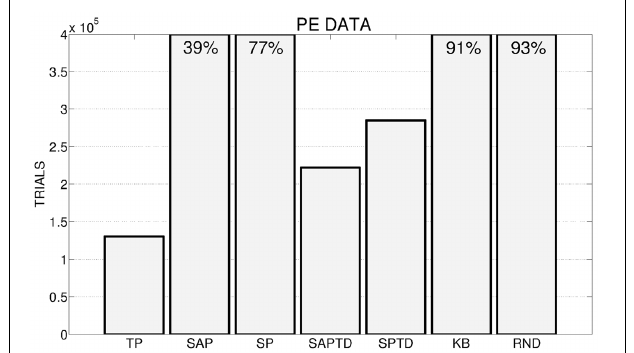
FIGURE 4 | Average number of trials needed by the different conditions to achieve an average performance of 95% in the 4 learnable tasks (average results of 180 replications: 20 replication by 9 learning rates for the systems with predictors, 180 replications for the random system) in the different experimental conditions. If a system has not reached 95% at the end of the 400,000 trials we report on the corresponding bar the average performance at the end of the